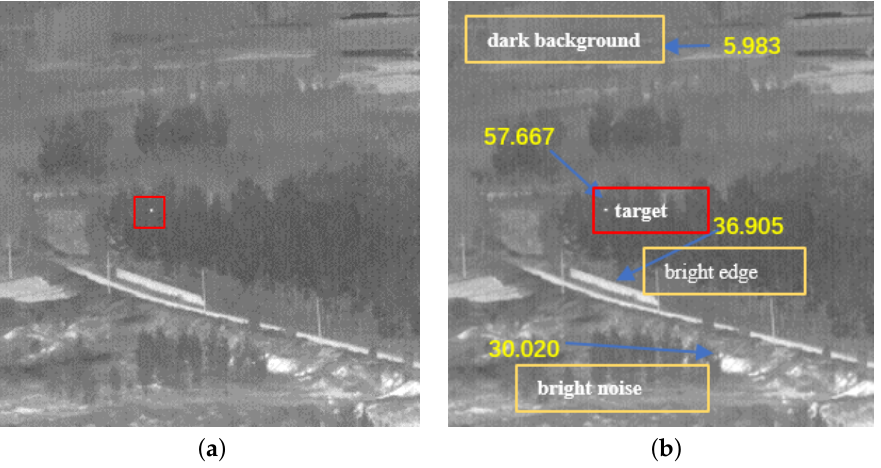
Figure 8. Variance difference at different regions; ( a ) is the infrared image, and the yellow numbers in ( b ) are the variances of different regions in ( a ).